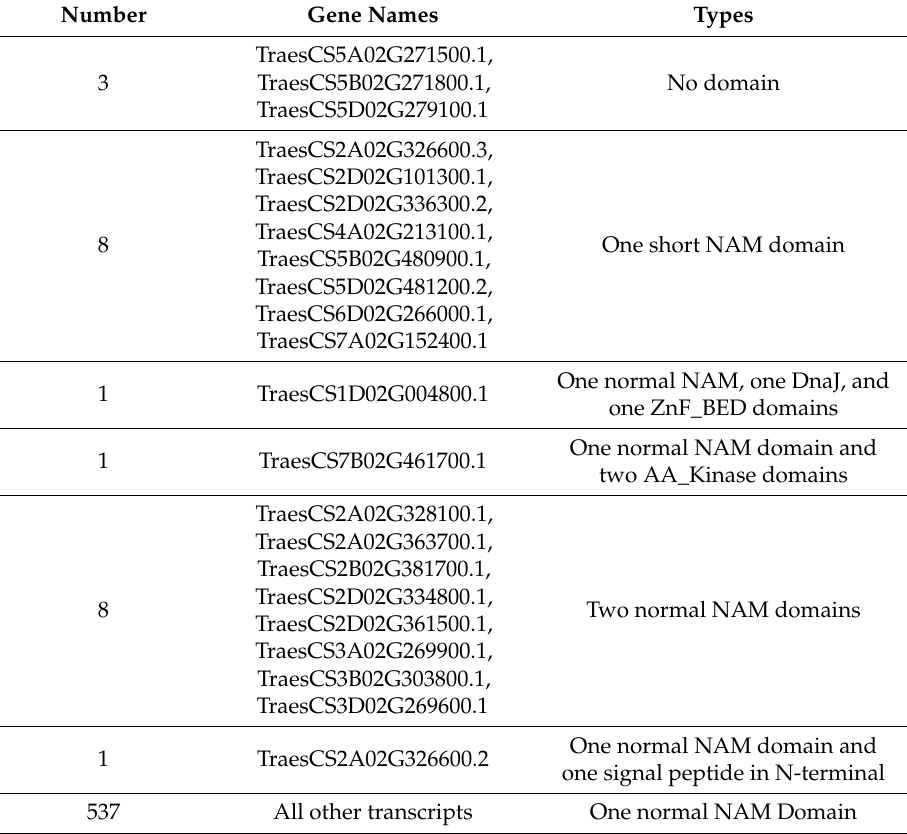
Table 1. Conserved-domain classification of 559 high-quality Triticum aestivum NAC (TaNAC) transcripts identified from IWGSC RefSeq